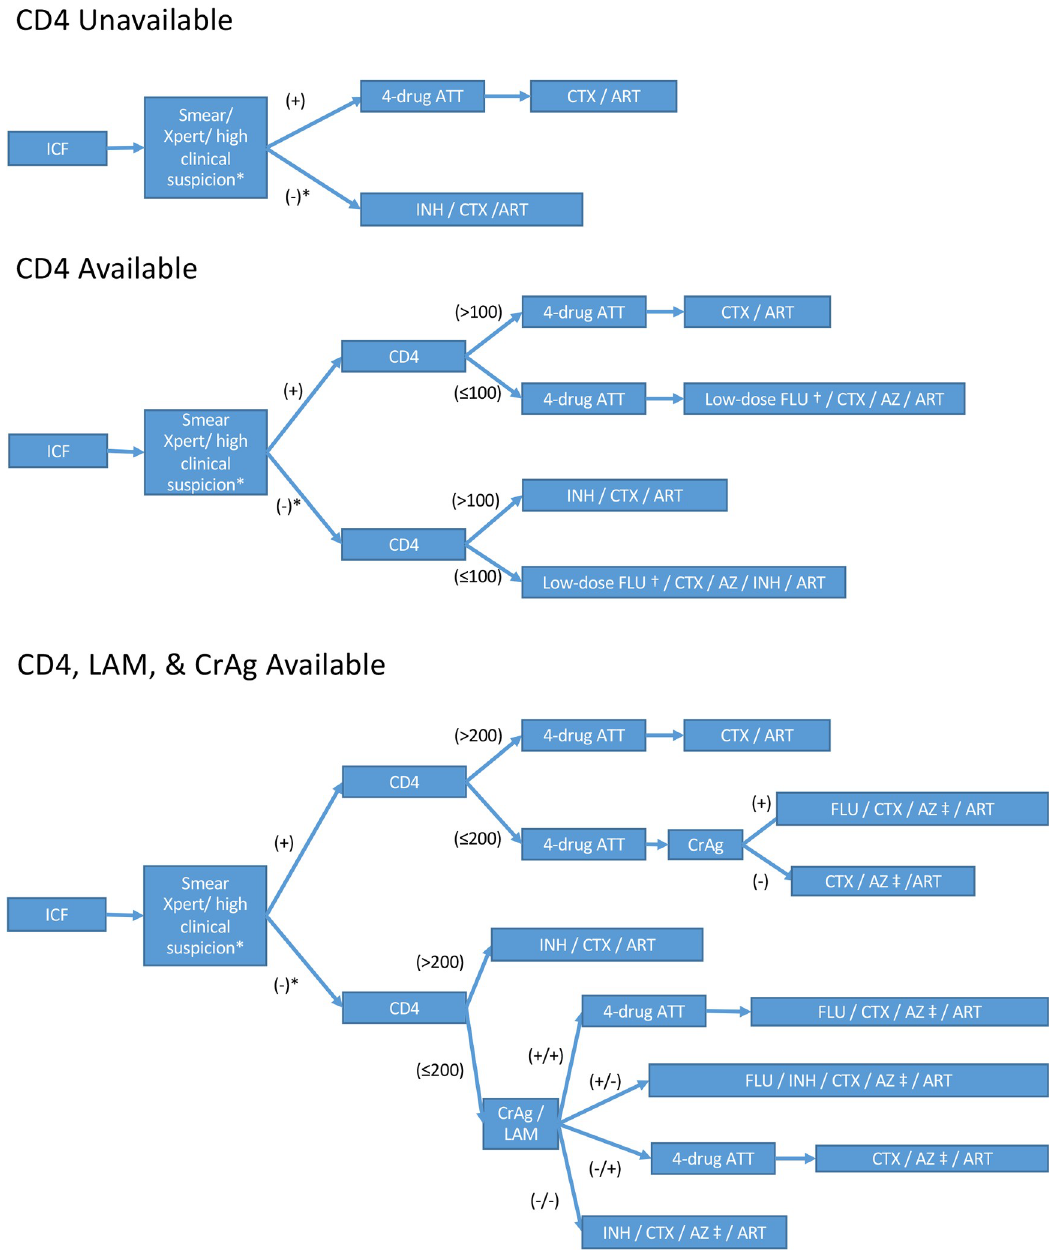
Fig 1. Resource-based approach for targeting OIs. � If smear or Xpert MTB/RIF is negative or unable to perform but suspicion for TB is high, consider further evaluation and/or empiric 4-drug treatment. † Low-dose FLU 100 mg/day for 12 weeks used